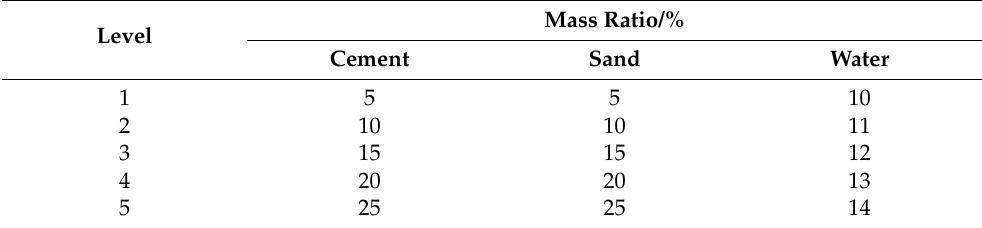
Table 3. Factor levels of similar